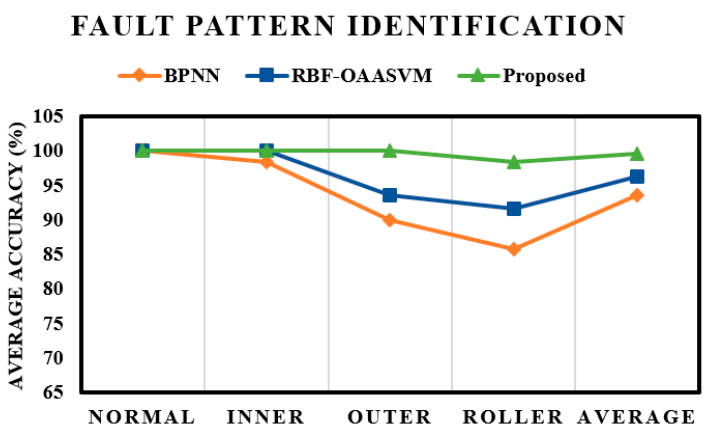
Figure 7. Bearing fault classification results for the first layer (i.e., the fault pattern recognition layer), BPNN and RBF-OAASVM stand for back-propagation neural network and radial basis function-one against all support vector machine, respectively.